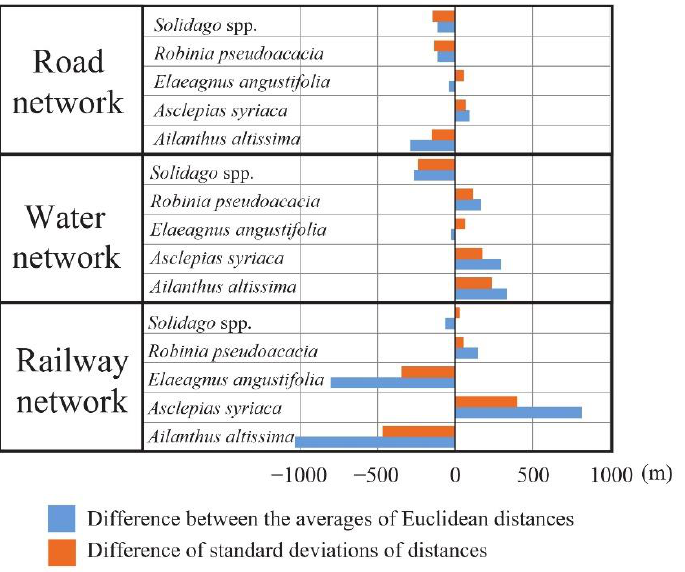
Figure 3. Difference in average and standard deviation of Euclidean distances between infected and non-infected LUCAS points and roads, railway networks, and green and blue infrastructure.